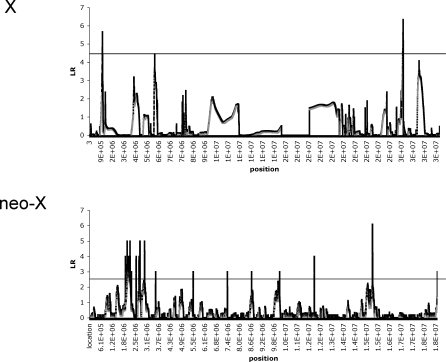
The Maximized Composite Likelihood Surface Calculated for Genes from the Ancestral X and the Neo-X ChromosomeThe horizontal line indicates the 5% cutoff values (LRcrit) as determined separately for the X (LRcrit = 4.5) and the neo-X (LRcrit = 2.7) by simulation under a neutral equilibrium model. More significant peaks are identified on the neo-X, suggesting that more recent selective sweeps have occurred on this chromosome.